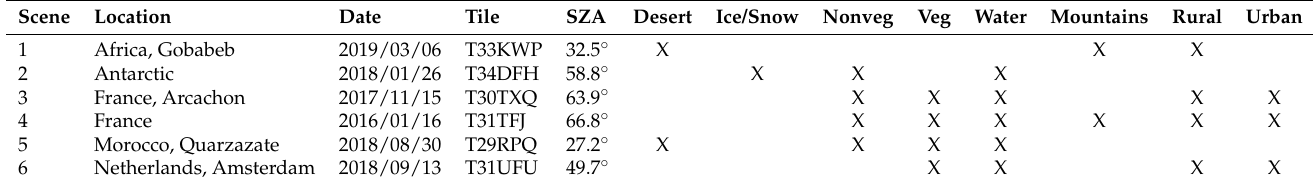
Table 1. Sentinel-2 level L1C test scenes. Information on scene climate, main surface cover, ru- ral/urban. (SZA = solar zenith angle).